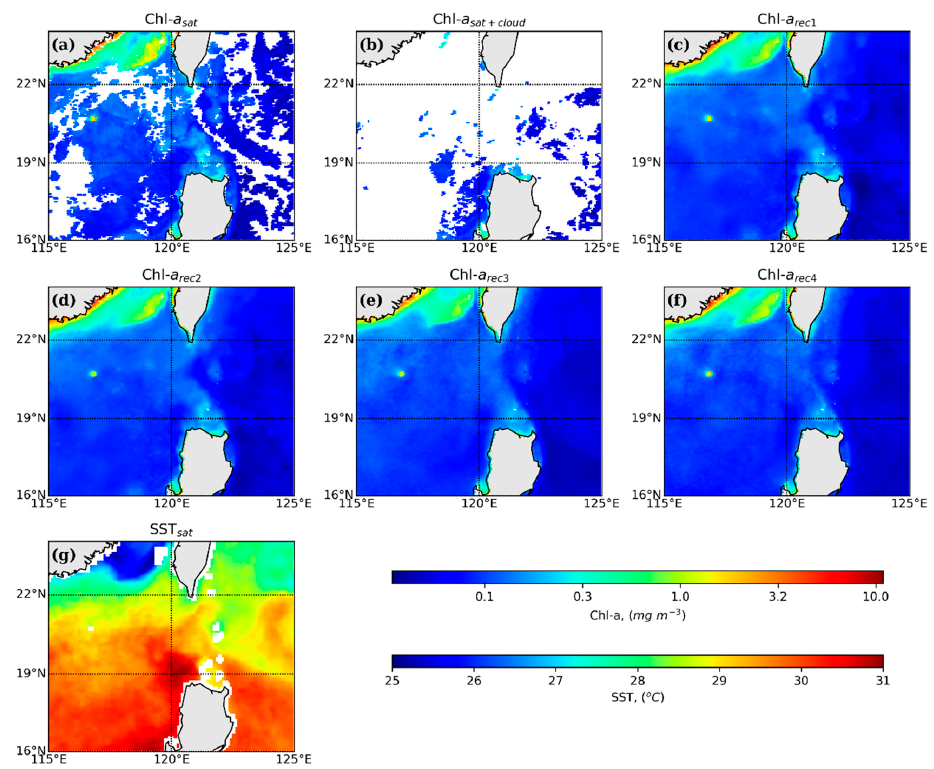
Figure 10. Daily reconstruction of 17 May, 2018: ( a ) original Chl- a sat ; ( b ) adding artificial cloud to original images Chl- a sat + cloud , ( c ) Chl- a rec1 , ( d ) Chl- a rec2 , ( e ) Chl- a rec3 , ( f ) Chl- a rec4 , and ( g ) SST sat .